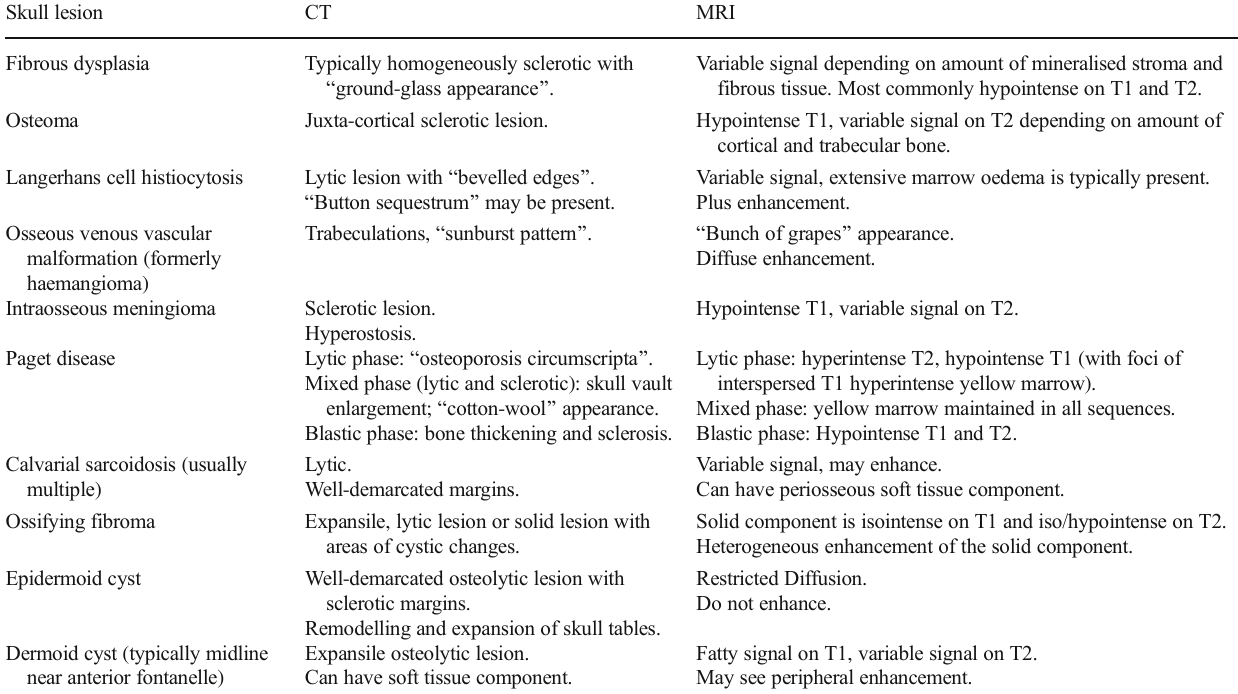
Table 2 Salient features of benign skull lesions on CT and MRI Skull lesion CT MRI Fibrous dysplasia Typically homogeneously sclerotic with Variable signal depending on amount of mineralised stroma and B ground-glass appearance ^ . fibrous tissue. Most commonly hypointense on T1 and T2. Osteoma Juxta-cortical sclerotic lesion.